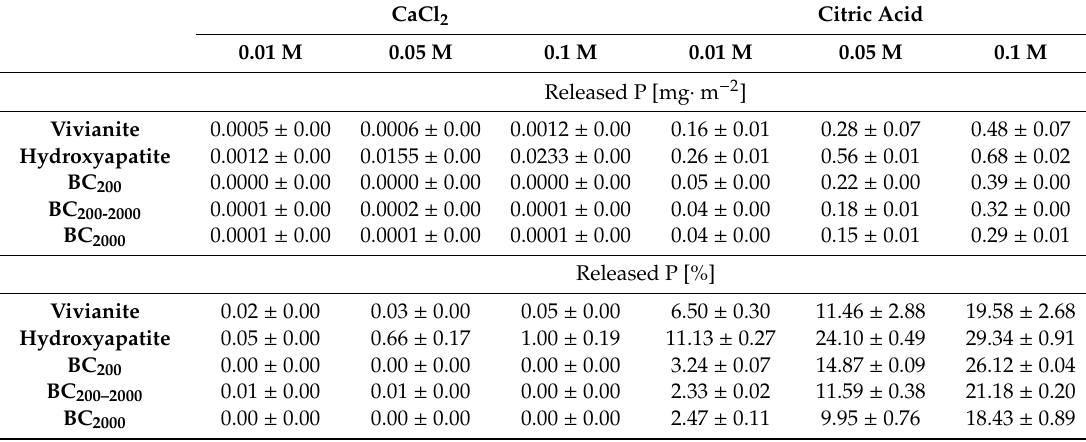
Table 3. E ffi ciency of P release after 168 h reaction time. Given are the mean* and standard deviations